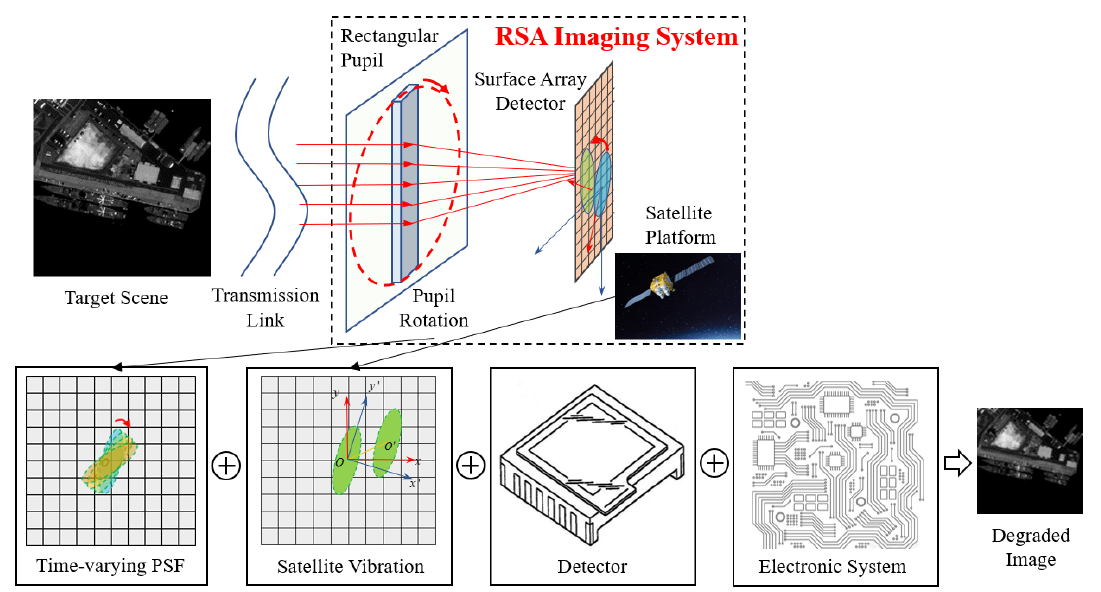
Figure 1. Diagrammatic sketch of the coupling relation of various errors of the rotating synthetic aperture (RSA) imaging system.